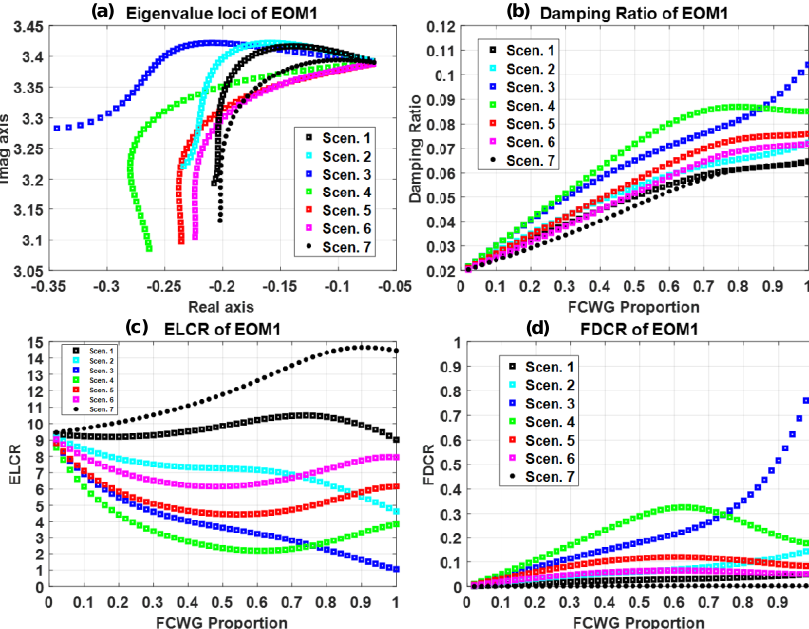
Figure 8. The interaction between PLL-FOM and EOM1 considering increasing FCWG proportion: ( a ) eigenvalue loci; ( b ) variation trend of damping ratio; ( c ) variation trend of ELCR; ( d ) variation trend of FDCR.